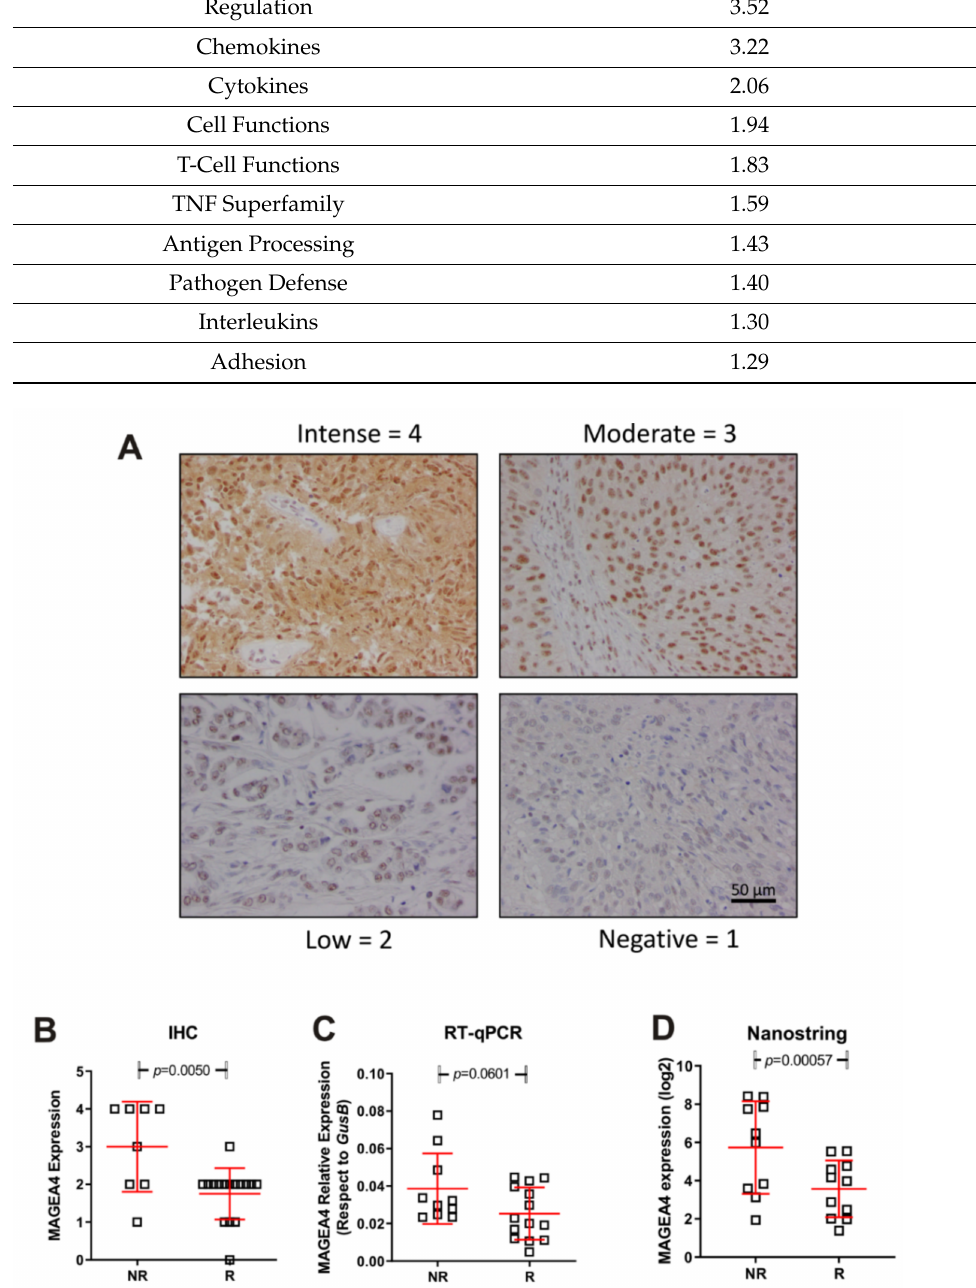
Figure 4. Expression of MAGEA4 in responders (R) and non-responders (NR). ( A ) Representative examples corresponding to the different IHC scores. ( B – D ) Summary of the MAGEA4 expression measured by IHC ( B ) mRNA expression by probe hybridization in nCounter Nanostring platform ( D ), mRNA expression by RT-qPCR ( C ). p -Values were estimated by un-paired T test. In summary, our results indicate that patients with low probability of benefit